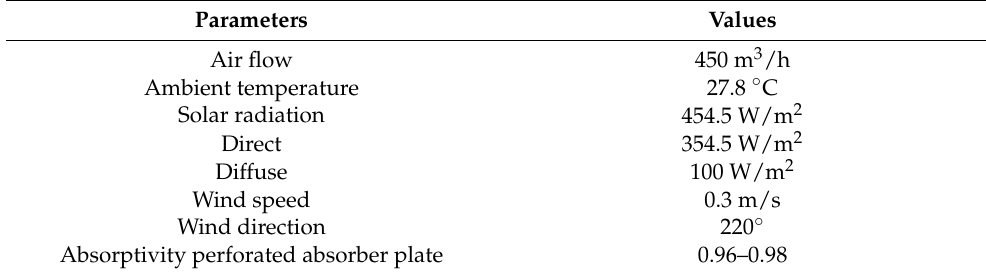
Table 2. Details of the case used for validation.